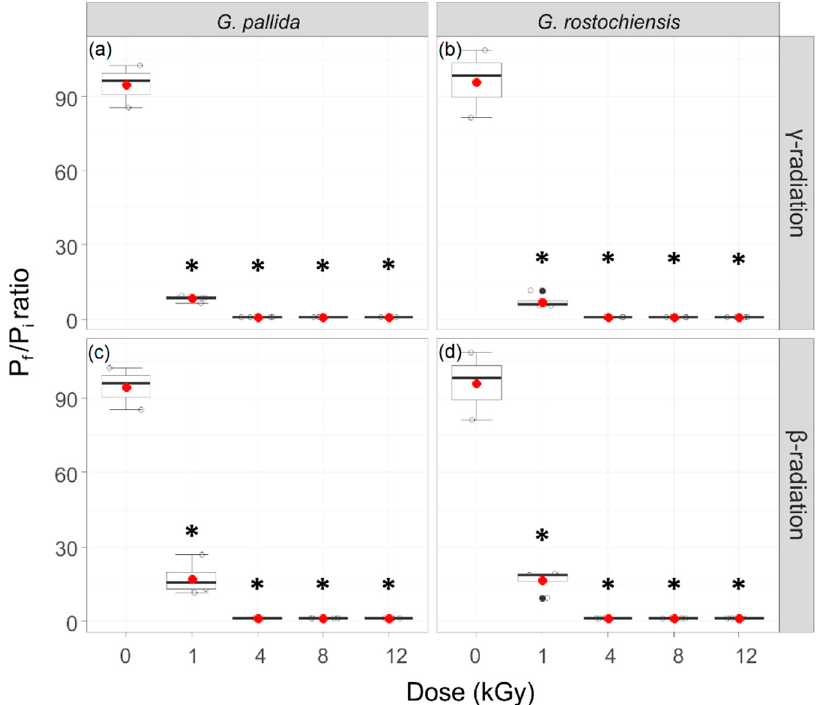
Figure 3. Cyst formation rates of irradiated G. pallida and G. rostochiensis . The ratio of newly formed cysts P f (final population) and the number of (P i ) initial cysts (50) added to the susceptible potato cultivar “Desireé”, 15 weeks after planting. P i cysts were treated with 0, 1, 4, 8 and 12 kGy of γ irradiation ( a , b ) or β irradiation ( c , d ). Data were analysed by the non-parametric Kruskal–Wallis test with a pairwise Wilcoxon post hoc test using adjusted p -values. Box–whisker plots display the median and mean (red dots) values of four replicates. Asterisks indicate the significant differences to the respective non-treated controls.